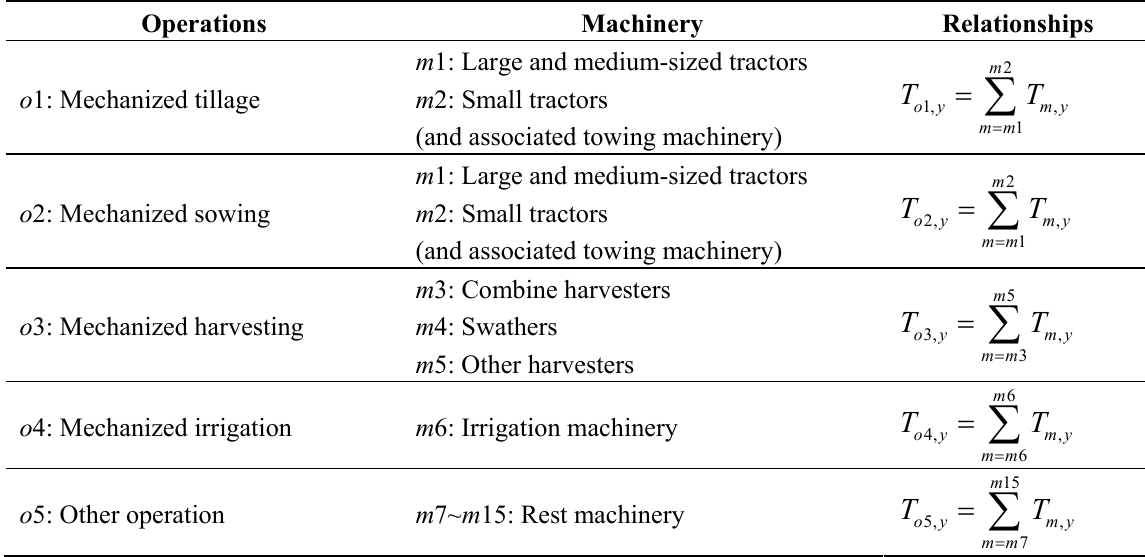
Table 1. The relationships between operations and machinery